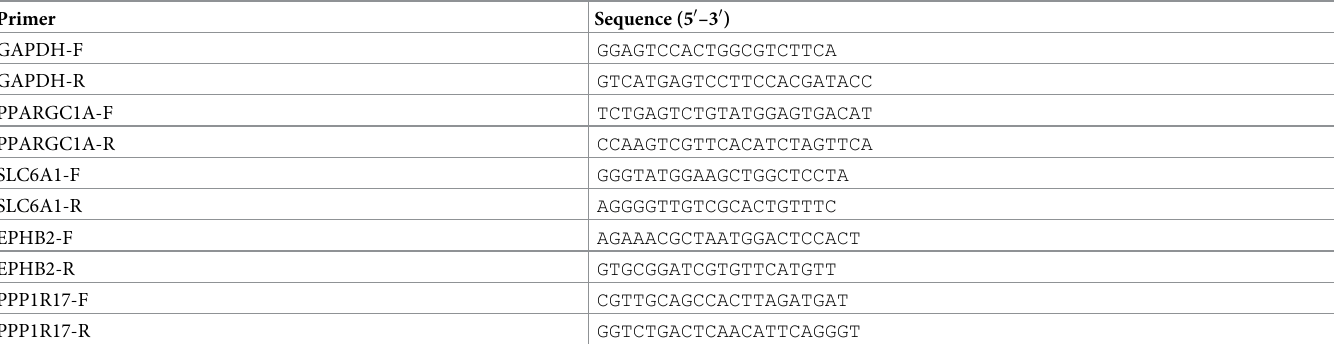
Table 2. Primer sequences used for quantitative real-time